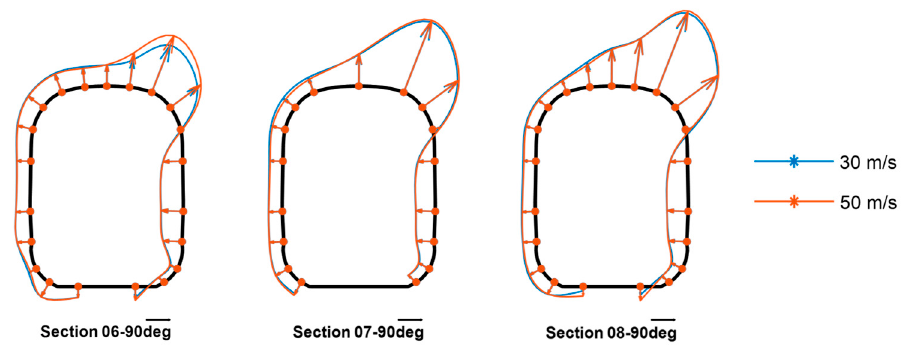
Figure 8. Pressure coefficient around the surface of the train. Wind tunnel test: wind speed 30 m/s and 50 m/s; wind yaw angle = 90°; train: ETR1000; scenario: STBR.